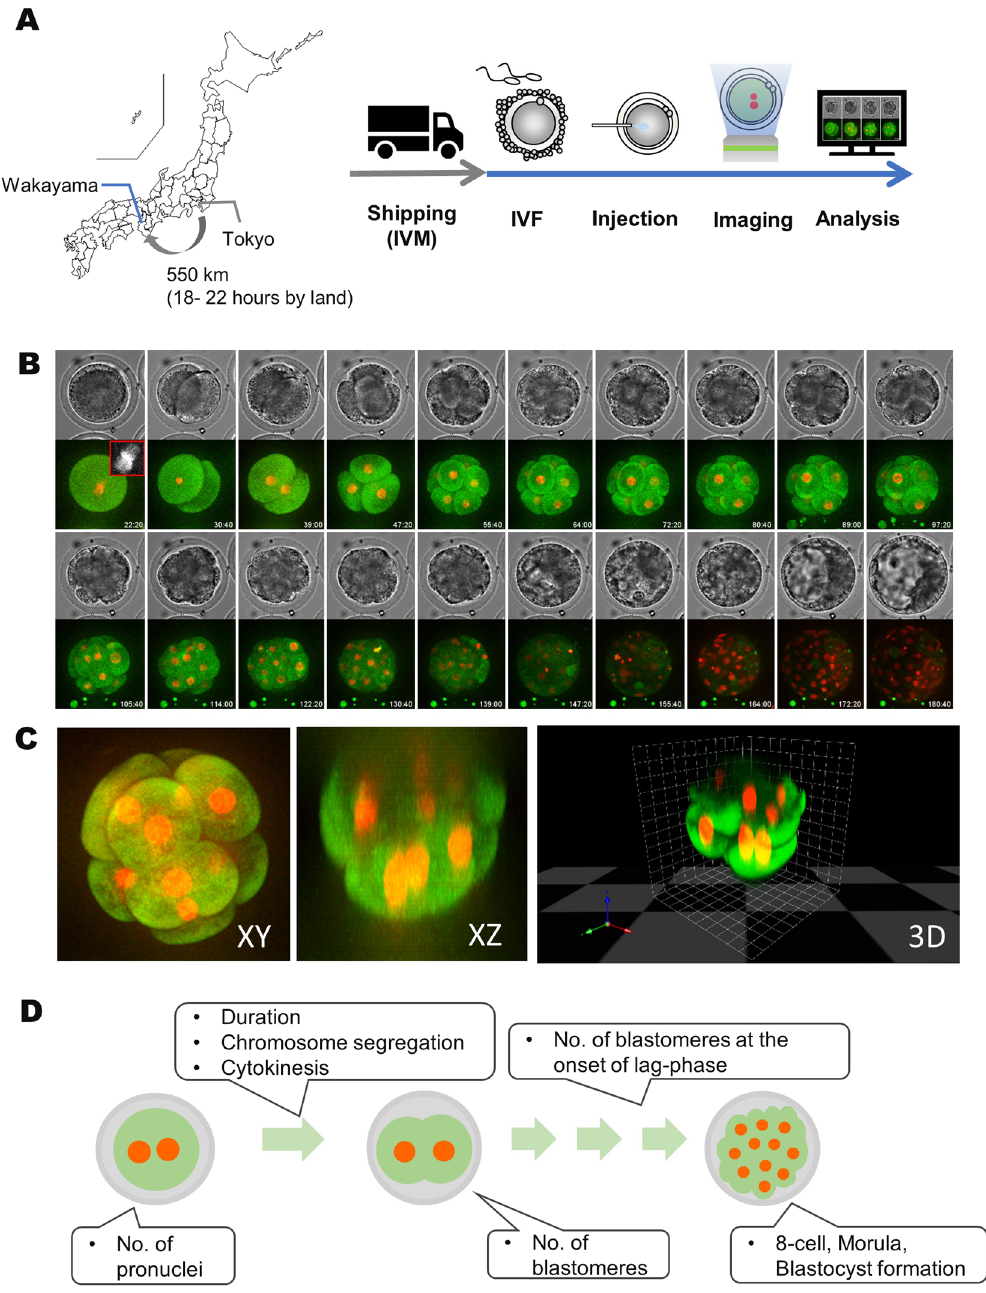
Figure 4. Schematic representation of experimental design. In Tokyo University of Agriculture Technology, Tokyo, Japan, COCs were collected from slaughterhouse-derived ovaries. The collected COCs were shipped while in vitro maturing (IVM) to Kindai University, Wakayama, Japan, where we performed live-cell imaging for this study. After arrival, in vitro fertilisation (IVF) was conducted for 6 h. mRNAs were injected into oocytes, in which polar bodies were observed, and live-cell imaging was performed for 8 days by CV1000. The obtained images were retrospectively analysed. A map was drawn by JapanPrefecturesMap function in Nippon package of R statistical software ( A ) 30 . 3D live-cell imaging of 369 embryos injected with mRNA encoding histone H2B- mCherry and EGFP- α -tubulin was performed from the one-cell to blastocyst stage for 8 days. Maximum intensity projections (MIP) were used for 2D image constrictions. Red and green represent histone H2B- mCherry (nuclei/chromosome) and EGFP- α -tubulin (microtubule), respectively ( B ). 2D/3D images of 8-cell embryos were constructed by ImageJ/Fiji and Volocity software. By optimising the imaging conditions, it was possible to obtain images up to the top nuclei/chromosome in the z-axis in lipid-rich bovine embryos ( C ). The number of pronuclei (PN), timing, chromosome segregation, and cytokinesis at first cleavage, number of blastomeres at end of first cleavage, number of blastomeres at the onset of lag-phase were retrospectively observed ( D